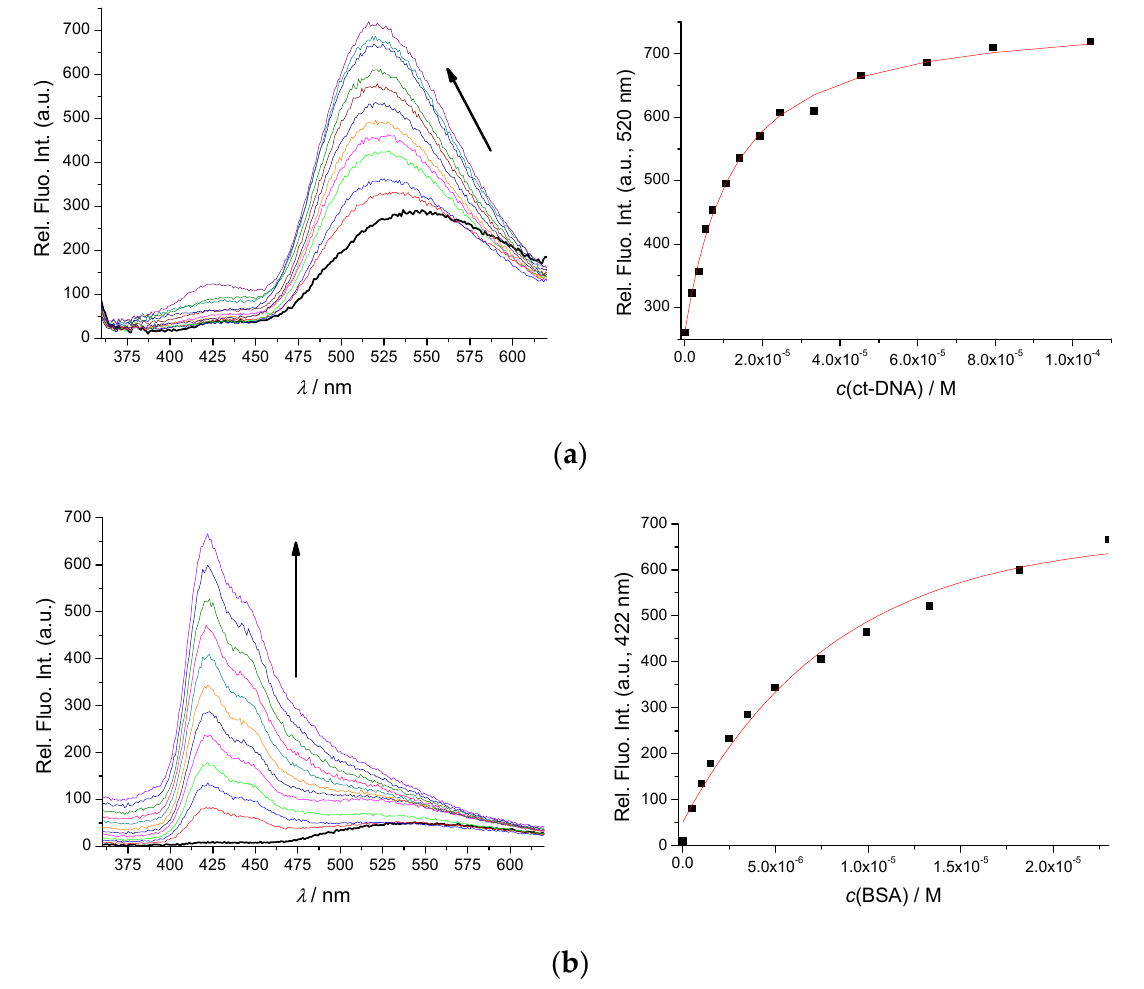
Figure 3. Changes in the fluorescence spectrum of 2 ( c = 5 × 10 − 7 M, λ exc = 319 nm, pH 5.0, sodium cacodylate buffer, I = 0.05 M) upon titration with ( a ) ct-DNA; ( b ) BSA.